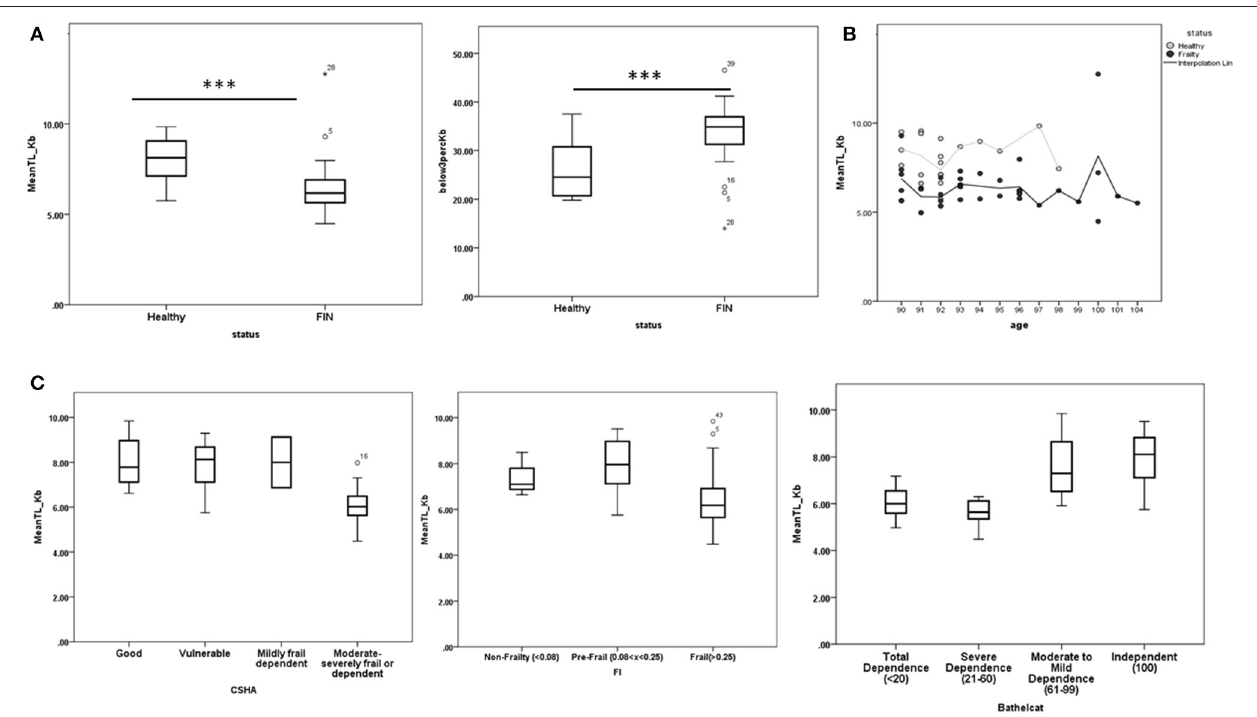
FIGURE 1 | (A) Distribution of telomere length and PBMCs with telomere length < 3Kb in the healthy and functionally impaired non-agenarian groups. Healthy nonagenarians showed both higher telomere length and lower percentage of PBMCs with telomere length < 3Kb (B) Telomere length in each group distributed by age. No clear relation can be observed. C) Distribution of telomere length after applying each measure of frailty and dependency to all the nonagenarians in the study. Higher frailty or dependency in Canadian Study of Health and Aging scale (CSHA > 5), Frailty index (FI > 0.25), and Barthel Index (Barthelcat < 61) were associated with lower telomere length. *** p <